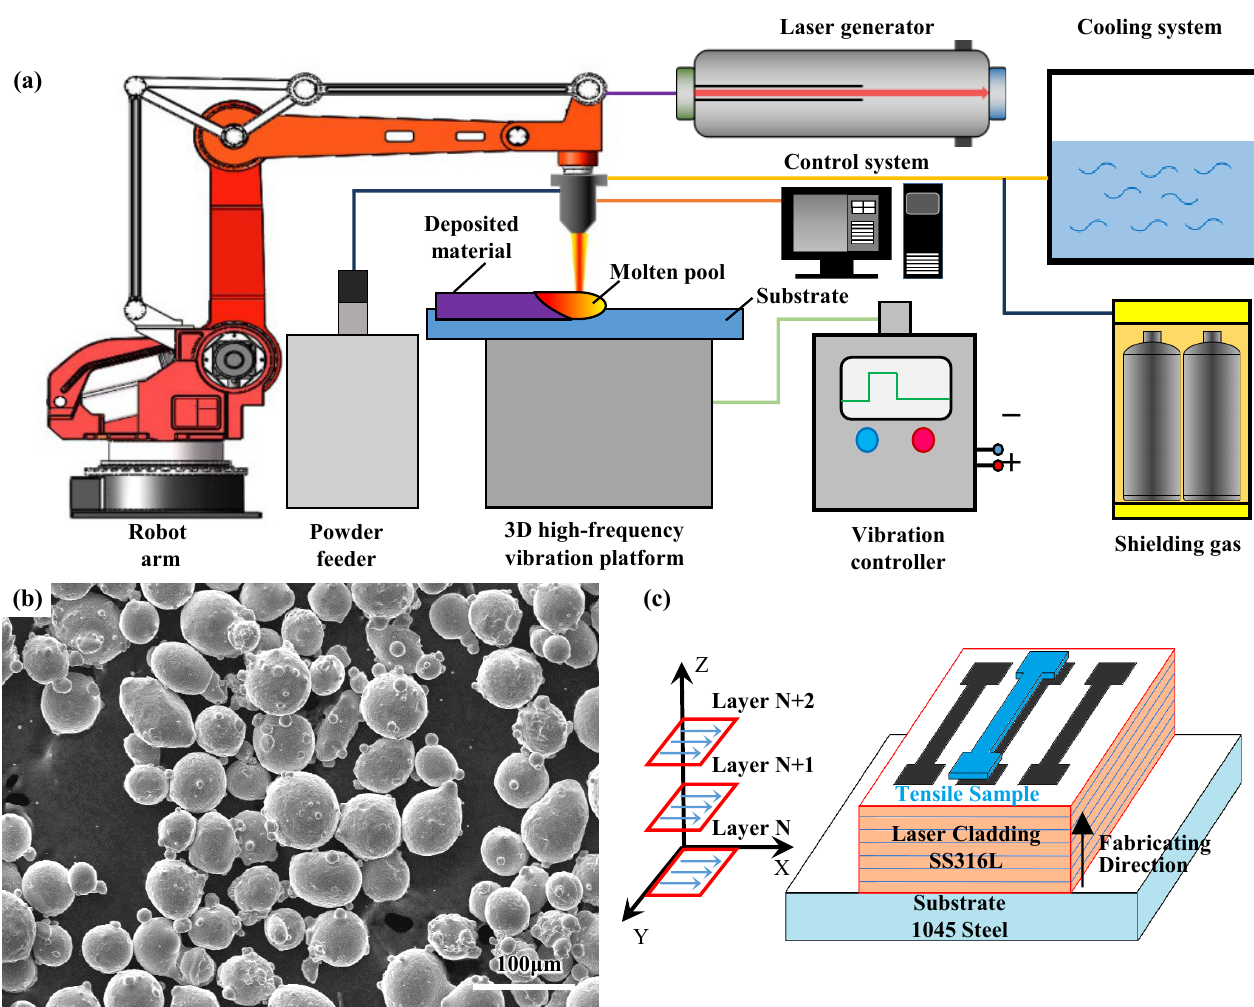
Figure 1. The experimental setup and materials: ( a ) diagram of the experimental setup; ( b ) SEM micrograph of SS316L powders; ( c ) schematic illustration of the sampling for tensile tests.